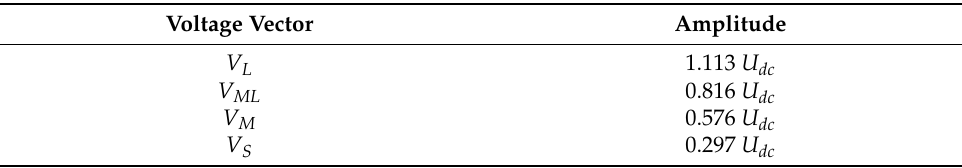
Table 1. Amplitude of space vector for six-phase VSI.